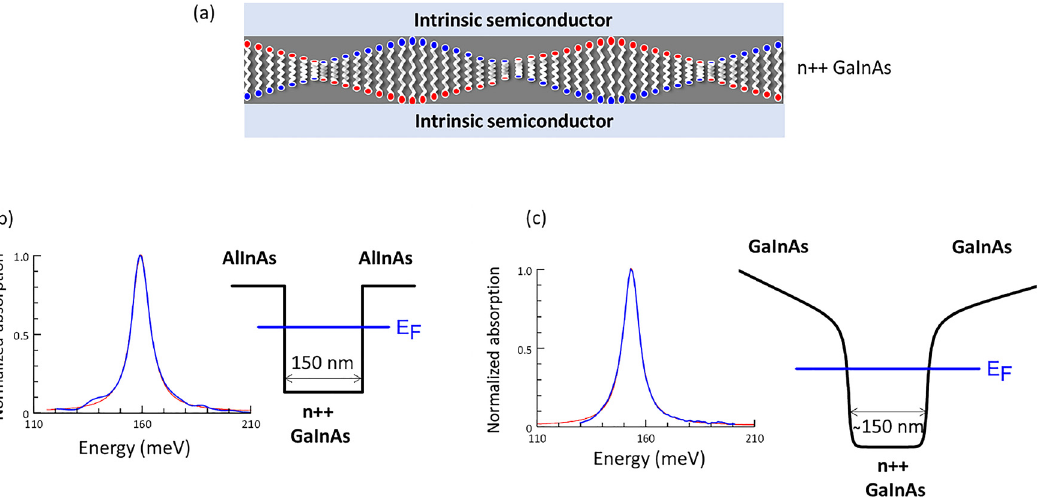
Figure 1: (a) Sketch of the system: a highly doped GaInAs layer embedded between two intrinsic semiconductor layers sustains a Berreman modecharacterizedbyadipolealongthegrowthdirection.(b)and(c)Conductionbandpro fi leandnormalizedabsorptionspectrummeasured at10 ° internalangle(blueline)forasampleinwhichthetwointrinsiclayersare(panelb)AlInAsbarriersor(c)intrinsicGaInAslayers.Redlines are Lorentzian fi t of the absorption